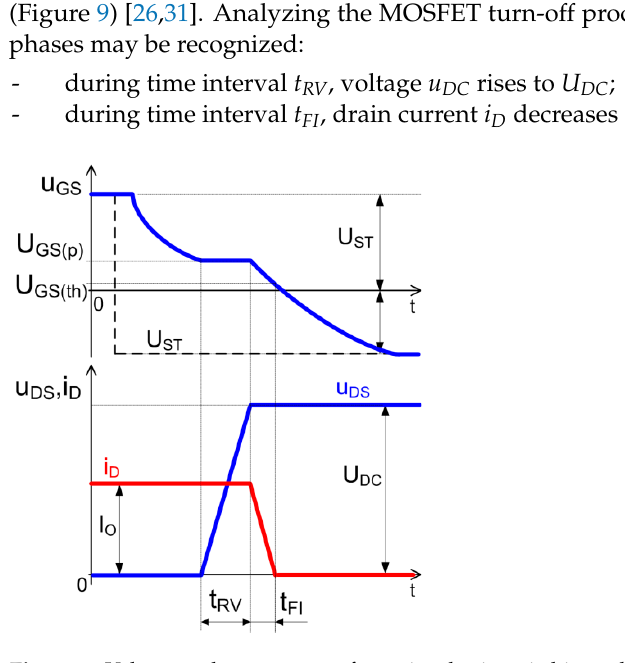
Figure 9. Voltage and current waveforms in a basic switching cell during the transistor turn-off process.